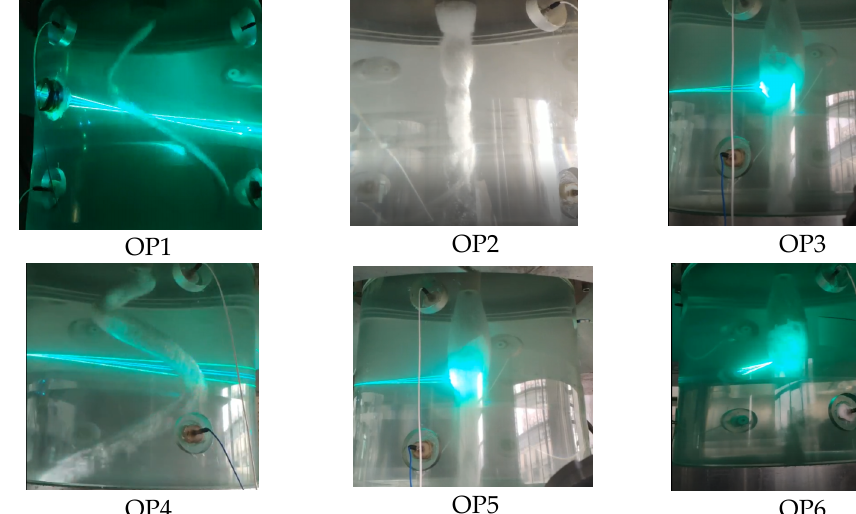
Figure 14. Vortex ropes at different operating points.